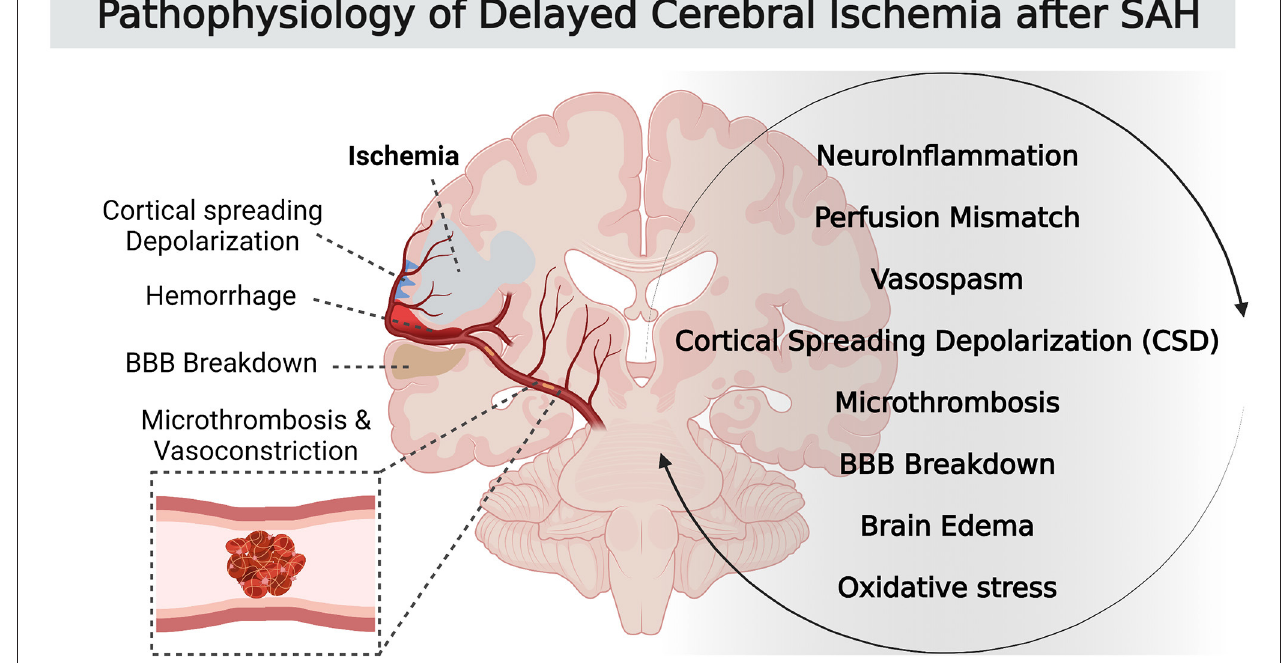
FIGURE 1 | Pathophysiology of DCI after